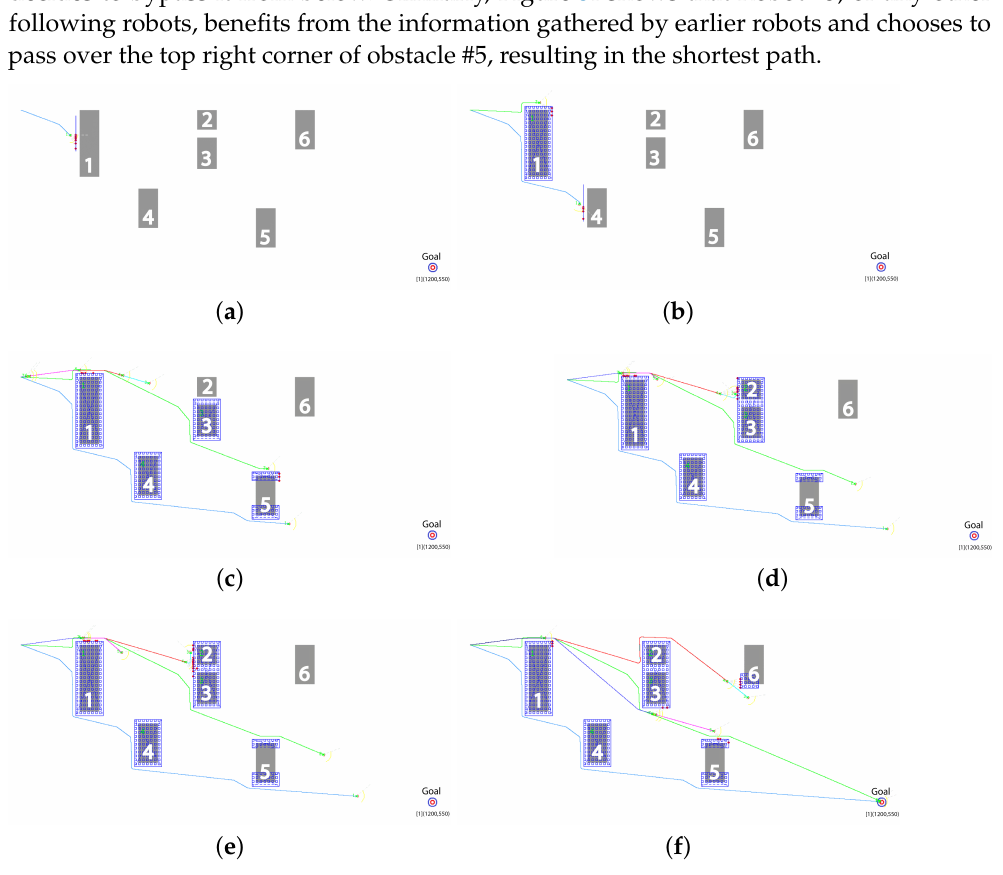
Figure 5. Simulation snapshots: showing the operation of the IWp-OA algorithm. ( a ) Robot 1 avoiding the first detected obstacle from the bottom edge. ( b ) Robot 2 circumvents the obstacle from above to discover an alternate route. ( c ) Robots 1 and 2 have partially discovered obstacle 5. ( d ) Robot 3 discovers obstacle 2, and utilizing fuzzification, combines it with the already discovered obstacle 3. ( e ) Robot 4 chooses the trajectory, by utilizing the broadcast information, to bypass obstacle 3 from below. ( f ) Robot 5 utilizes information provided by all other robots and chooses the optimal